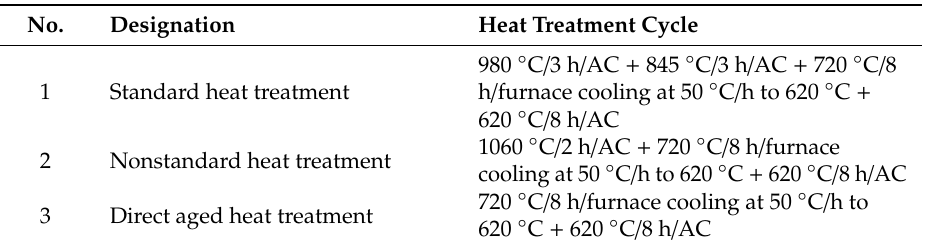
Table 1. Heat treatment schemes of IN706 alloy.